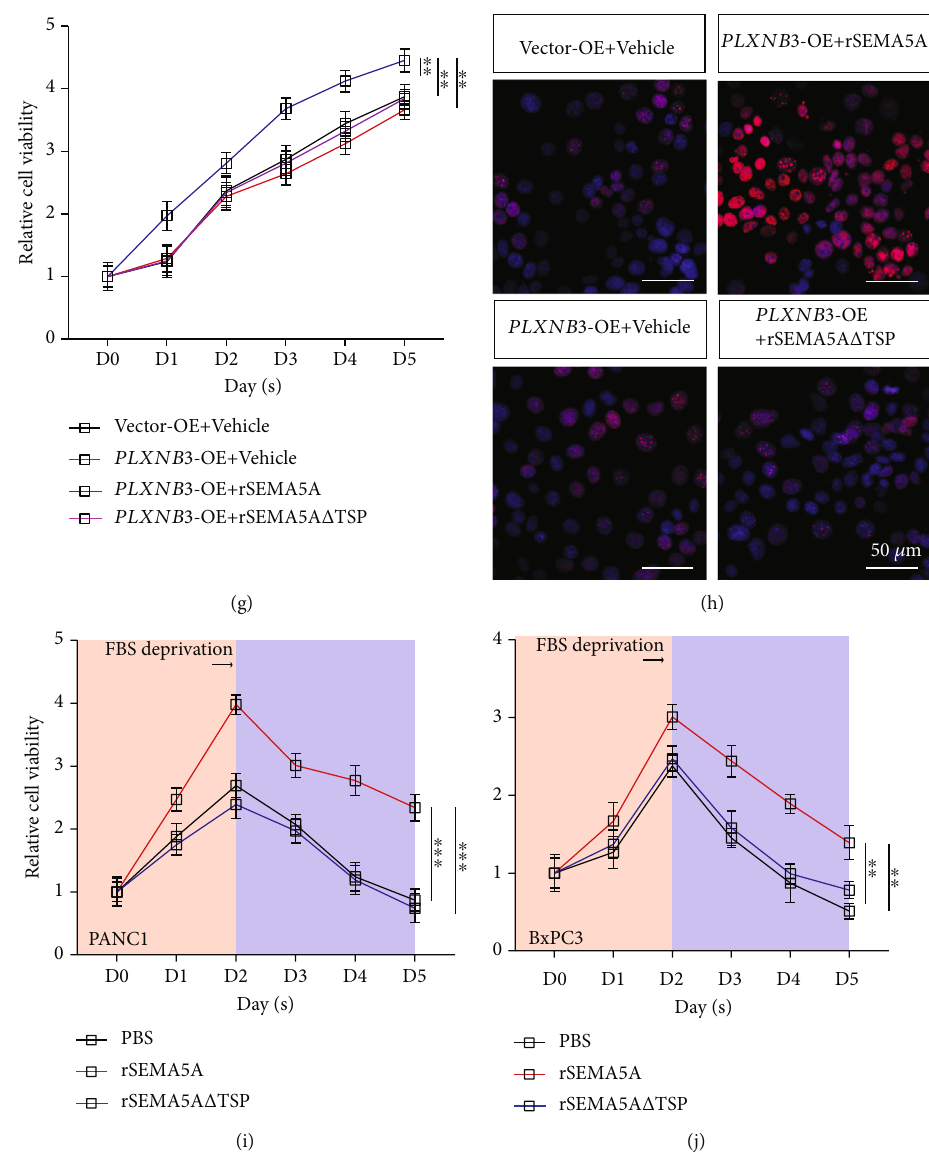
Figure 4: SEMA5A-PLXNB3 axis promotes liver metastasis in vivo. (a, b) Relative cell viability of PANC1 shCTRL or PANC1 sh PLXNB3 cells cultured with or without M1 TAM (a) or M2 TAM (b) conditional medium measured by CCK-8 kit ( n = 5 repeats per group, mean ± s : e : m : , repeat measures ANOVA). ∗∗∗ P < 0 : 001 ; NS: no signi fi cance. (c, d) Relative cell viability of BxPC3 shCTRL or BxPC3 sh PLXNB3 cells cultured with or without M1 TAM (c) or M2 TAM (d) conditional medium measured by CCK-8 kit ( n = 5 repeats per group, mean ± s : e : m : , repeat measures ANOVA). ∗∗∗ P < 0 : 001 ; NS: no signi fi cance. (e) Relative cell viability of PANC1 was cultured in M2 TAM conditional medium experienced IP of SEMA5A. ( n = 5 repeats per group, mean ± s : e : m : , repeat measures ANOVA). ∗∗∗ P < 0 : 001 . (f) Structure of SMEA5A full length and SEMA5A- Δ TSP. (g) Relative cell viability of AsPC1 PLXNB3 -OE in the presence or absence of SEMA5A and SEMA5A- Δ TSP ( n = 5 repeats per group, mean ± s : e : m : , repeat measures ANOVA). ∗∗ P < 0 : 01 . (h) EdU staining was performed on AsPC1 PLXNB3 -OE in the presence or absence of SEMA5A and SEMA5A- Δ TSP (3 fi elds assessed per sample). EdU, red; DAPI, blue; scale bars, 50 μ m. (i, j) Cell survival ability was assessed on PANC1 (i) and BxPC3 (j) cell line with administration of rSEMA5A or SEMA5A- Δ TSP ( n = 5 repeats per group, mean ± s : e : m : , repeat measures ANOVA). ∗∗ P < 0 : 01 ; ∗∗∗ P < 0 : 001